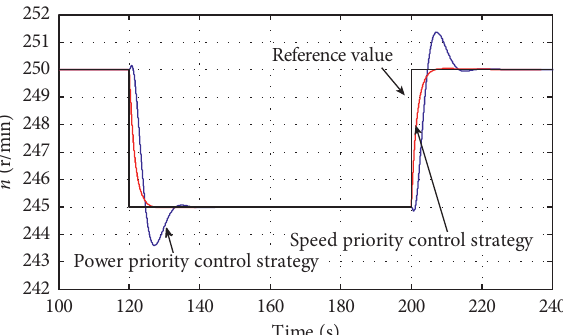
Figure 33: Speed comparison diagram when P